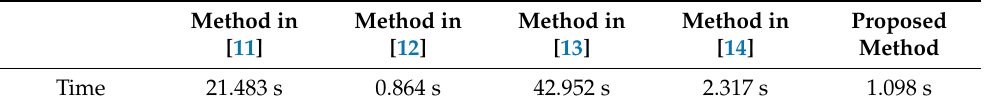
Table 4. Calculation time of different